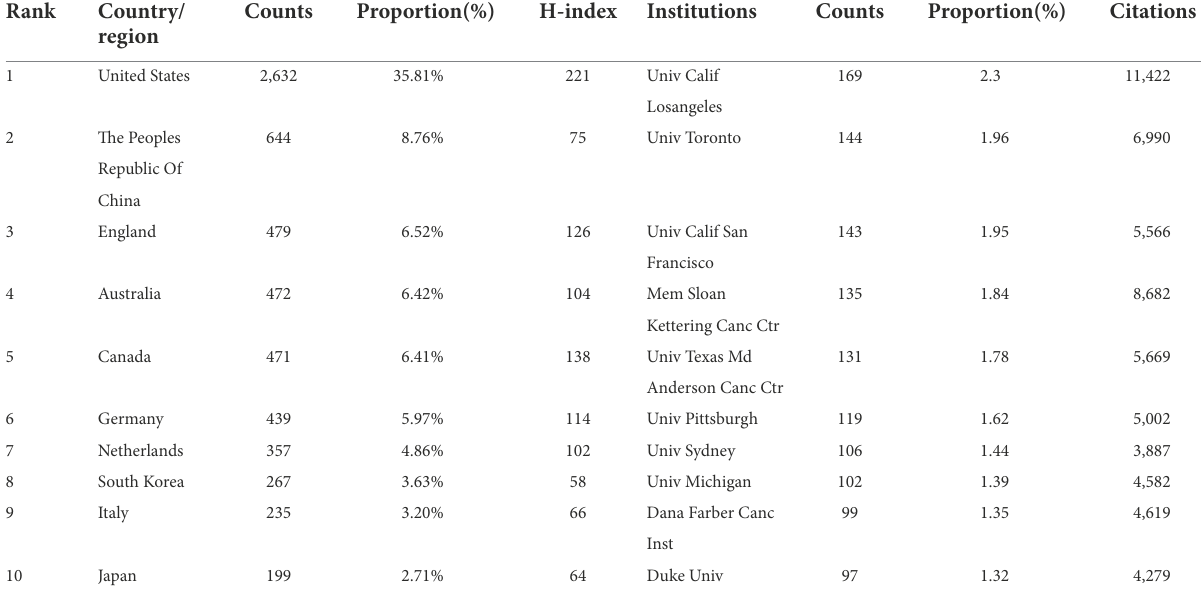
TABLE 2 The main countries, regions, and institutions contributing to publications on depression in breast cancer. Rank Country/ Counts Proportion(%) H-index Institutions Counts Proportion(%) region